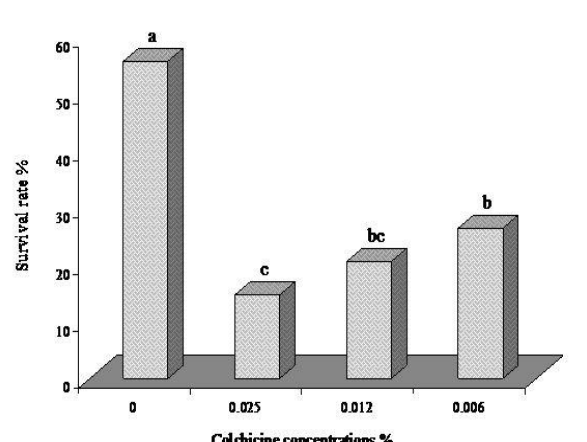
Fig. 3. The survival rate under affecting of colchicine-irrigation